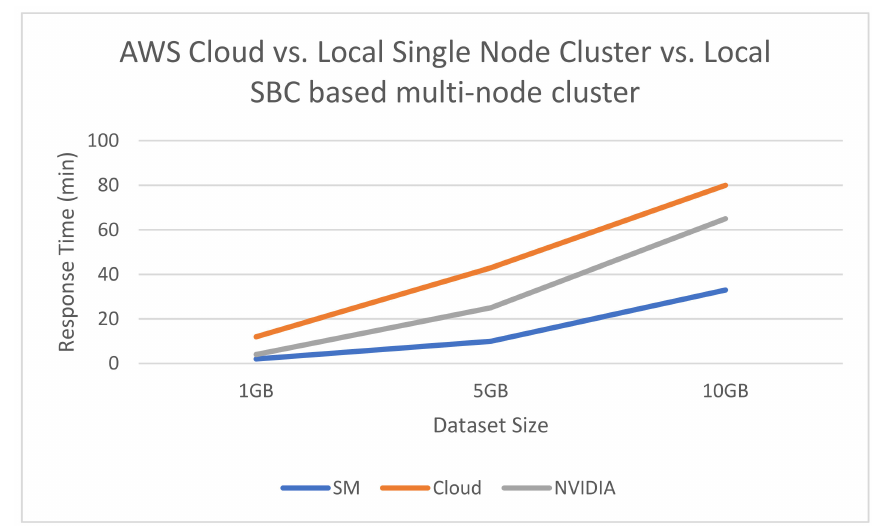
Figure 13. Comparison of the different execution times.